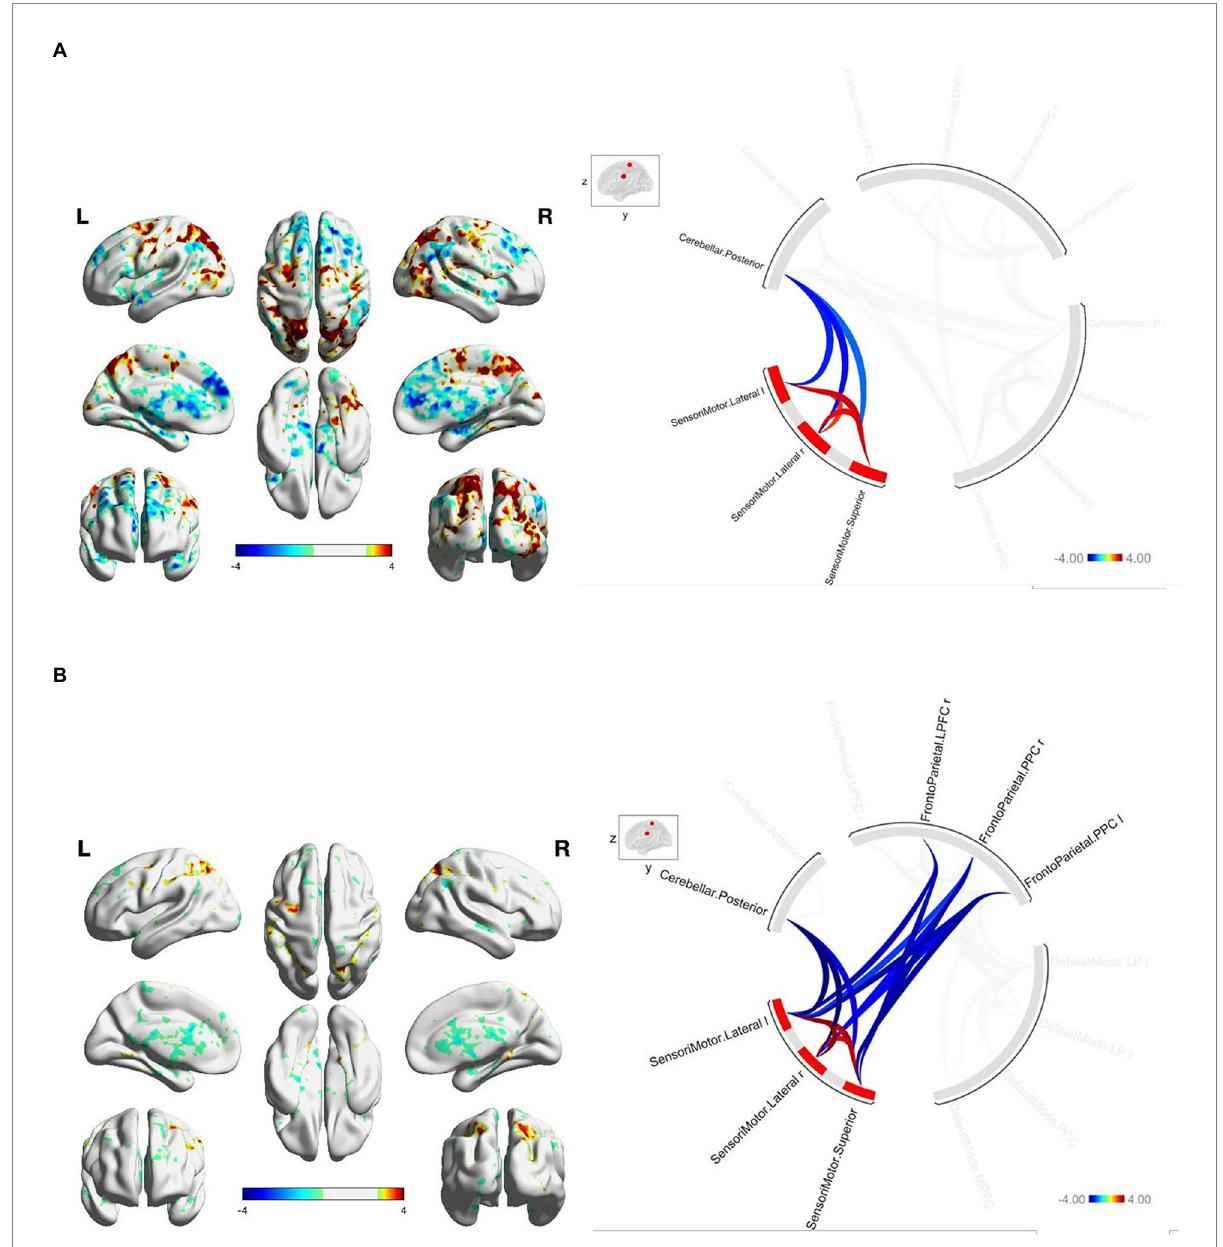
FIGURE 2 (A) FGA-related SMN connectivity at baseline. For connectome ring: bottom right quadrant contains nodes of the DMN, top right quadrant contains nodes of the FPN, the top left and bottom left quadrants contain nodes of the cerebellum and SMN. At baseline greater FGA score associated with: greater within-network connectivity within the SMN (uncorrected p < 0.01); lower connectivity between the SMN and cerebellum (uncorrected p < 0.01). (B) FGA-related SMN connectivity over 26-weeks (26 week – baseline). For connectome ring: bottom right quadrant contains nodes of the DMN, top right quadrant contains nodes of the FPN, the top left and bottom left quadrants contain nodes of the cerebellum and SMN. At 26-Weeks greater FGA score was correlated with: greater within-network connectivity within the SMN (uncorrected p < 0.01); lower connectivity between the SMN and cerebellum (uncorrected p < 0.01); lower connectivity between the SMN and FPN (uncorrected p < 0.01); Statistical brain maps were generated via general linear model (Z > 2.7, p < 0.05 FWE